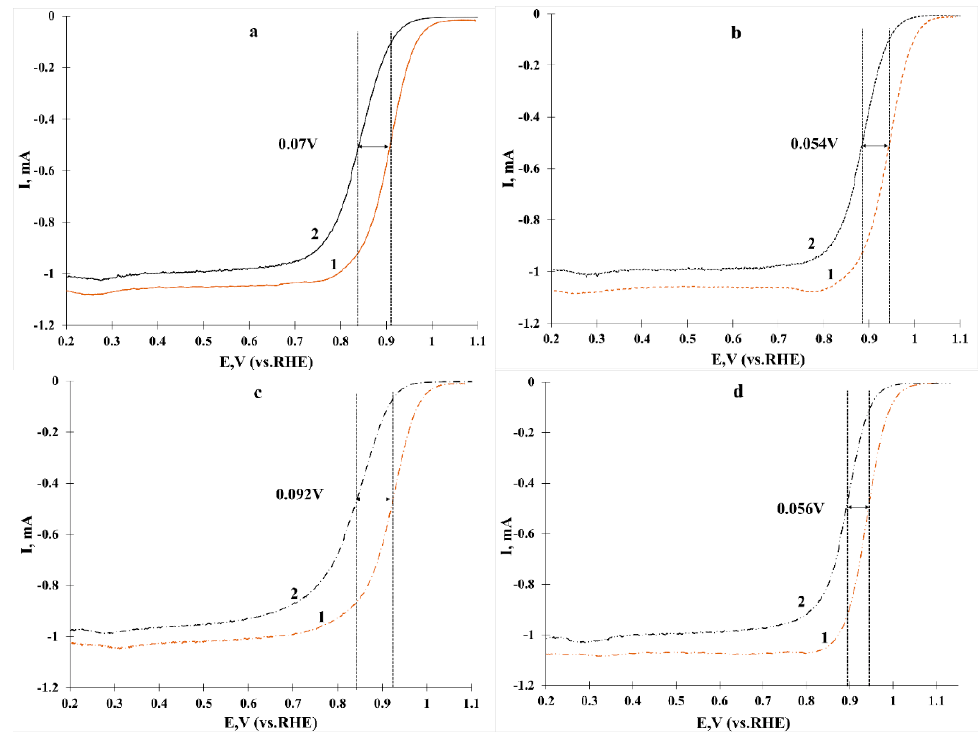
Figure 8. LSV curve for ORR at different rotation speeds ( a ) and the corresponding dependences 1/ I k vs. ω − 1/2 at potential of 0.90 V. ( b ) Rotation speed 400, 900, 1600, 2500 rpm, potential sweep rate is 20 mVs − 1 . Electrolyte—0.1 M HClO 4 solution saturated with O 2 .